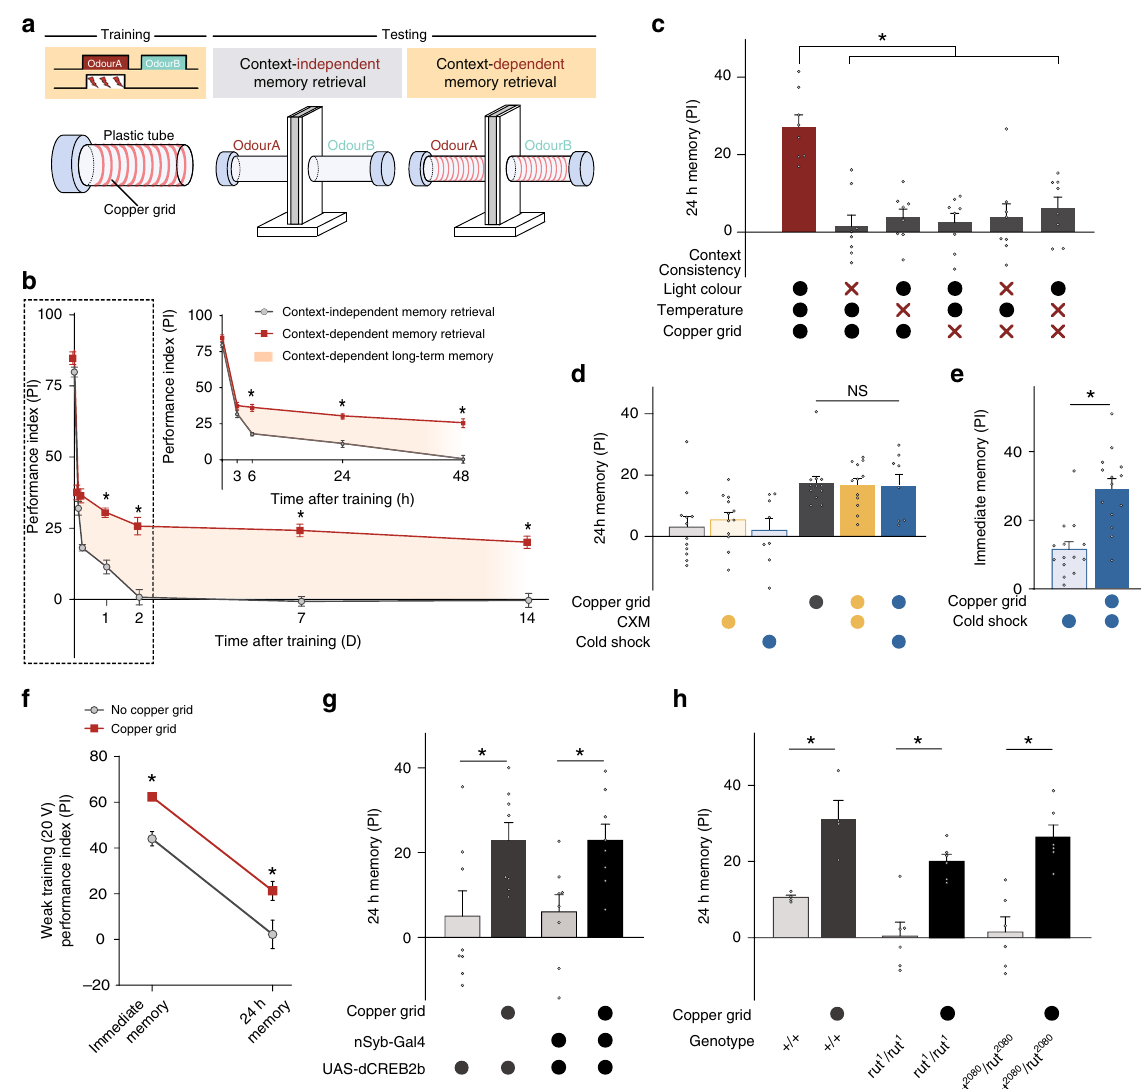
Fig. 1 Reinstating encoding context makes cLTM retrievable. a Basic experimental schemes. Left: aversive olfactory classical conditioning. The training tube contains a copper grid surface to deliver the electric shock. Middle: classical memory testing in the T-maze. Right: modi fi ed testing with context reinstatement. The testing arms contain a copper grid to reinstate training context. b Memory retention curves tested with different methods. Context reinstatement enables context-dependent long-term memory (cLTM) to be retrieved using conditioned odours. The cLTM is measurable 3 h after training and lasts for at least 14 days without decay ( n = 10 – 12). c cLTM retrieval requires multiple contextual conditions all matched. Any inconsistent contextual condition (i.e. light colour, temperature or absence of copper grid) abolishes cLTM retrieval ( n = 8). Crosses denote different conditions from training and circles denote same conditions. d Protein synthesis inhibitor (cycloheximide) and cold-shock treatment cannot destroy cLTM ( n = 8 – 12). e Copper grid improves 3-min memory performance after cold shock ( n = 14). f Both immediate memory (3 min) and 24-h memory are signi fi cantly improved when the copper grid is present after weak training with a 20-V electric shock, which avoids the ceiling effect that occurs immediately after norma training ( n = mean performance indices ± SEM; individual data points are displayed as dots. Asterisks denote a signi fi cant difference (* P < 0.05 by ANOVA or t